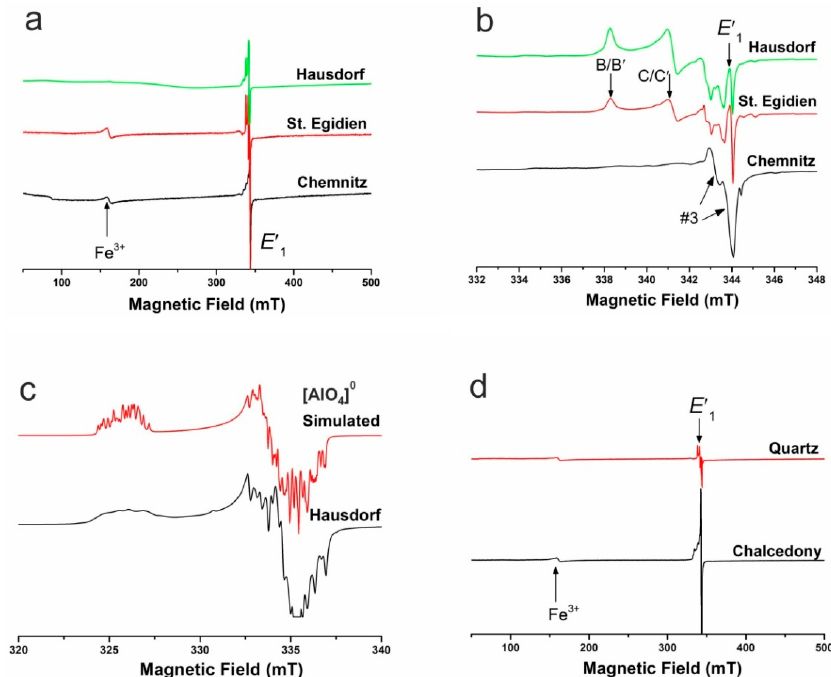
Figure 11. Powder EPR spectra of agate samples from Hausdorf, St. Egidien and Chemnitz (Saxony, Germany); ( a ) wide scans (microwave power of 2 mW and 295 K) showing a rhombic Fe 3+ center as well as a pronounced E ′ 1 center in all samples; ( b ) narrow scan for the central magnetic field region (microwave power of 20 mW and 295 K) showing multiple species of silicon-vacancy hole centers (B/B ′ , C/C ′ , and #3); ( c ) narrow scan of the central magnetic field region (microwave power of 20 mW and 85 K) showing the [AlO 4 ] 0 center and silicon-vacancy hole centers in the agate from Hausdorf; also shown for comparison is a simulated spectrum of the [AlO 4 ] 0 center (data from Walsby et al. [116]); ( d ) wide scans (microwave power of 2 mW and 295 K) showing that the E (cid:48) 1 center in chalcedony part of the agate sample from St. Edigien has a markedly higher intensity than its counterpart in macrocrystalline quartz from the center of the agate geode.